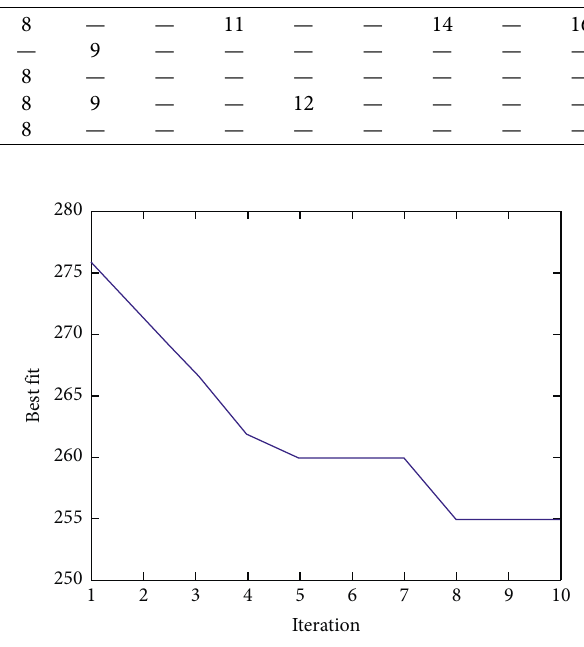
Figure 1: The trend of changes in the value of the objective function in each iteration. Table 12: Sequence of job 1